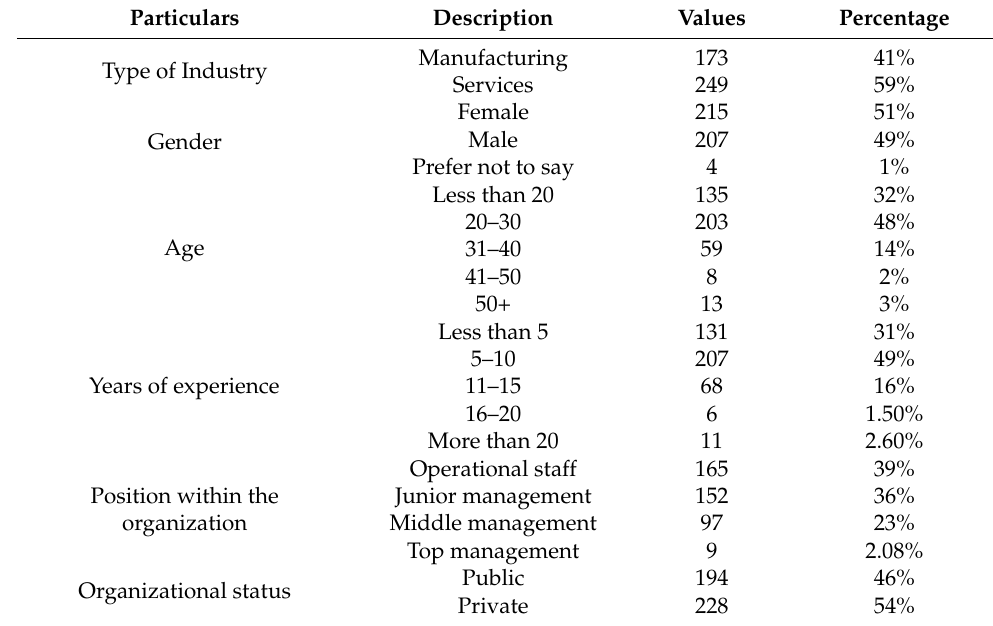
Table 1. Demographic Characteristics of Respondents ( n =